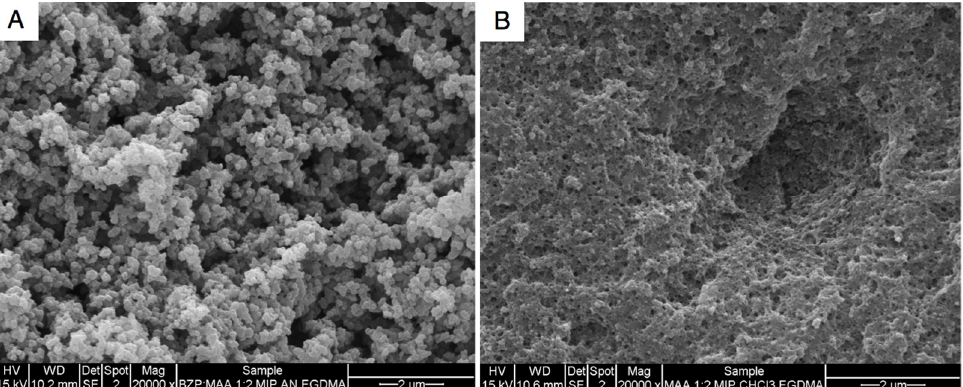
Figure 3. SEM images for ( A ) E 7 2 -MIP CH3CN and ( B ) E 7 2 -MIP CHCl3 obtained at 20,000× magnification, at 15.0